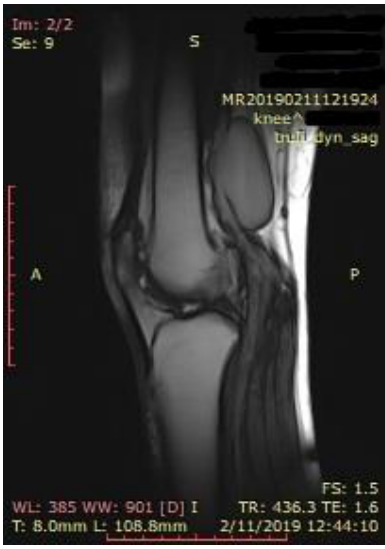
Figure 2. Magnetic resonance (MRI) of the knee, longitudinal axis view, showing the anatomy and location of the popliteal vein aneurysm.